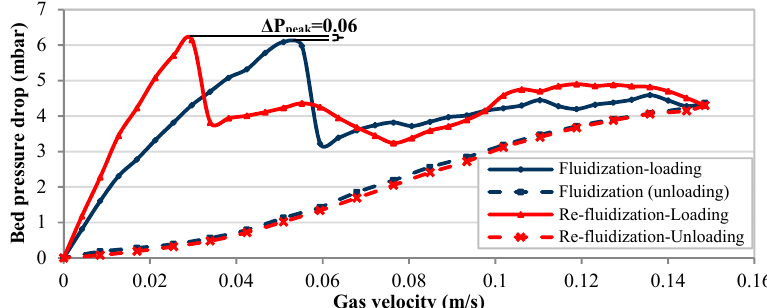
Figure 8. Fluidization and re-fluidization behaviors (after compression at 40 kPa) for a mixture of 30% of ultra-fine + 70% of fine particles.